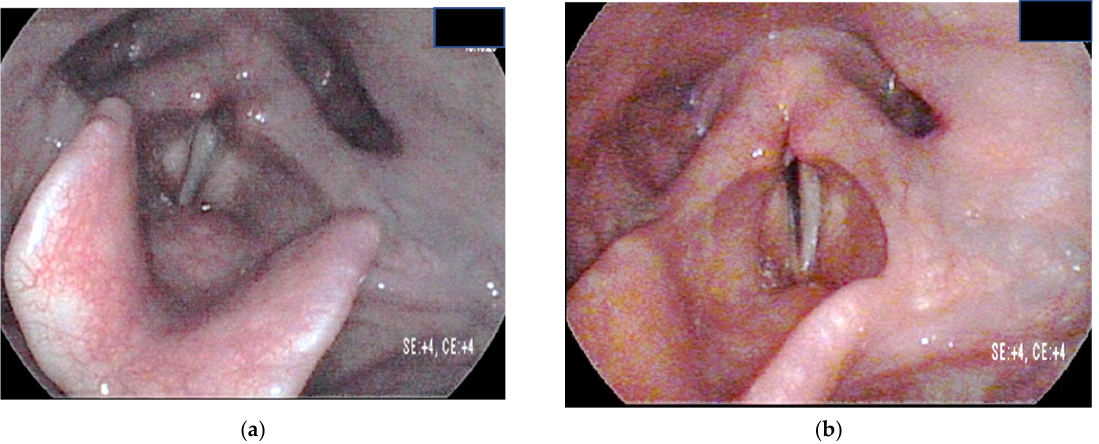
Figure 4. Stroboscopy images of Case 4 ( a ) preoperatively with maximal abduction and ( b ) post- arytenoidectomy.